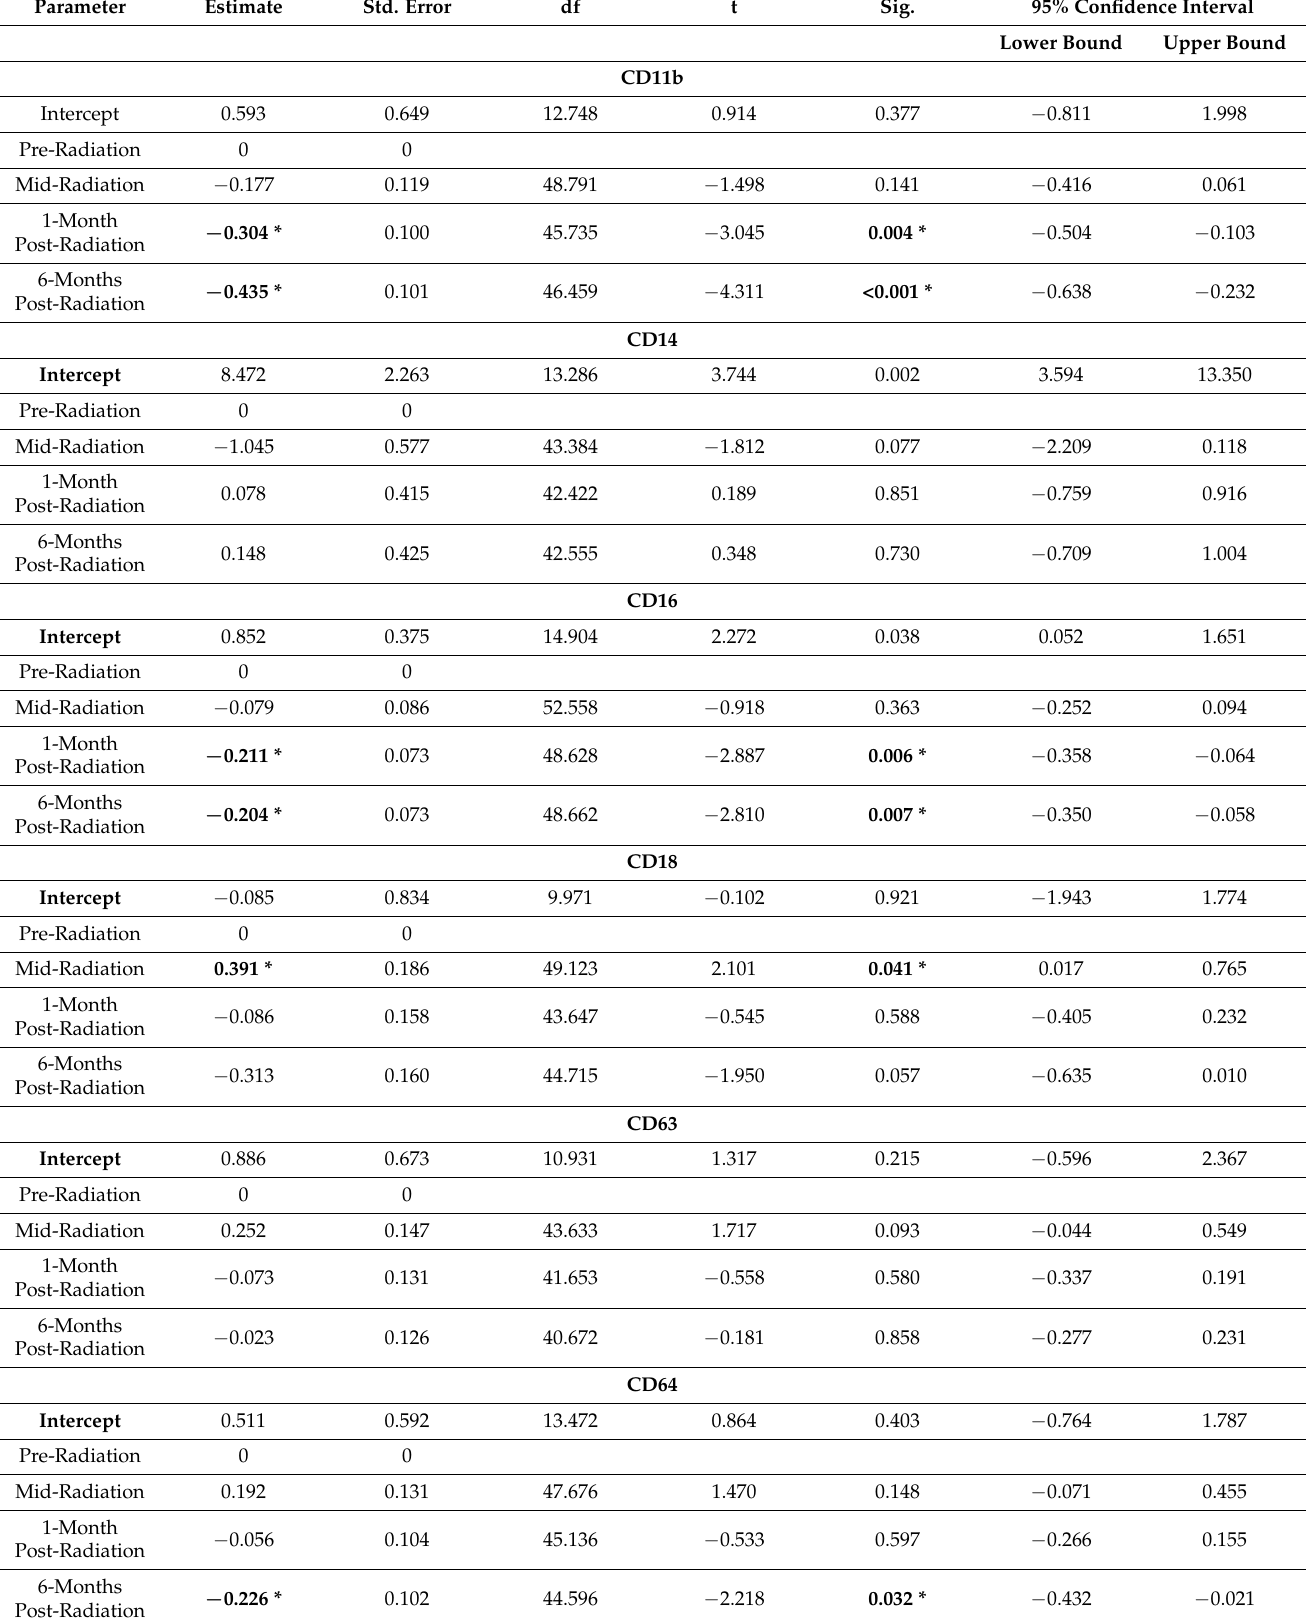
Table A12. The fixed effect estimates for the oPMN marker